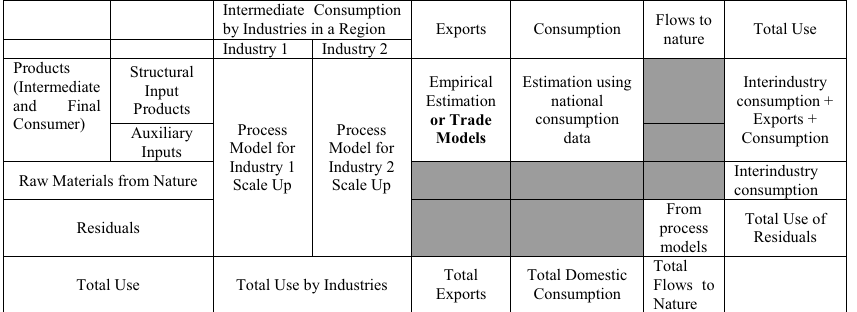
Table 2 Use table for a region from process models and empirical